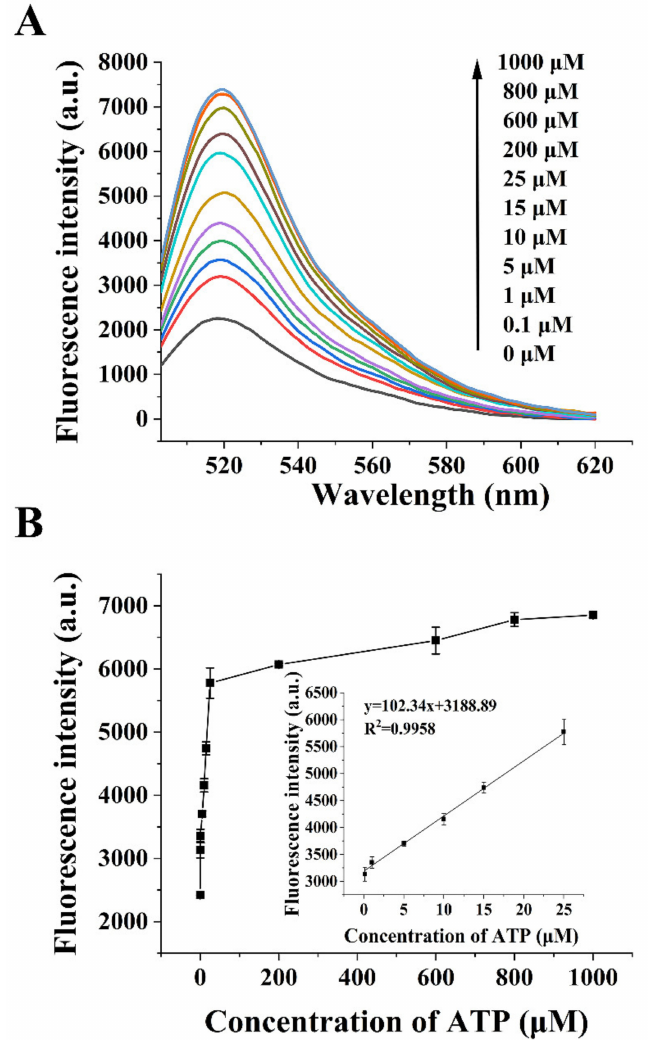
Figure 5. ( A ) fluorescence emission spectra in the presence of different concentrations of ATP; ( B ) the fluorescence intensity in relation to the ATP concentration. The linear relationship is shown in the